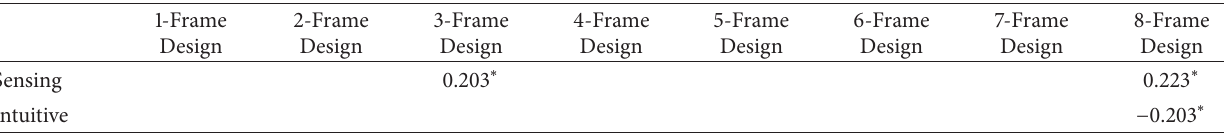
Table 24: Correlation between the preferences of design proposed against Sensing-Intuitive learning